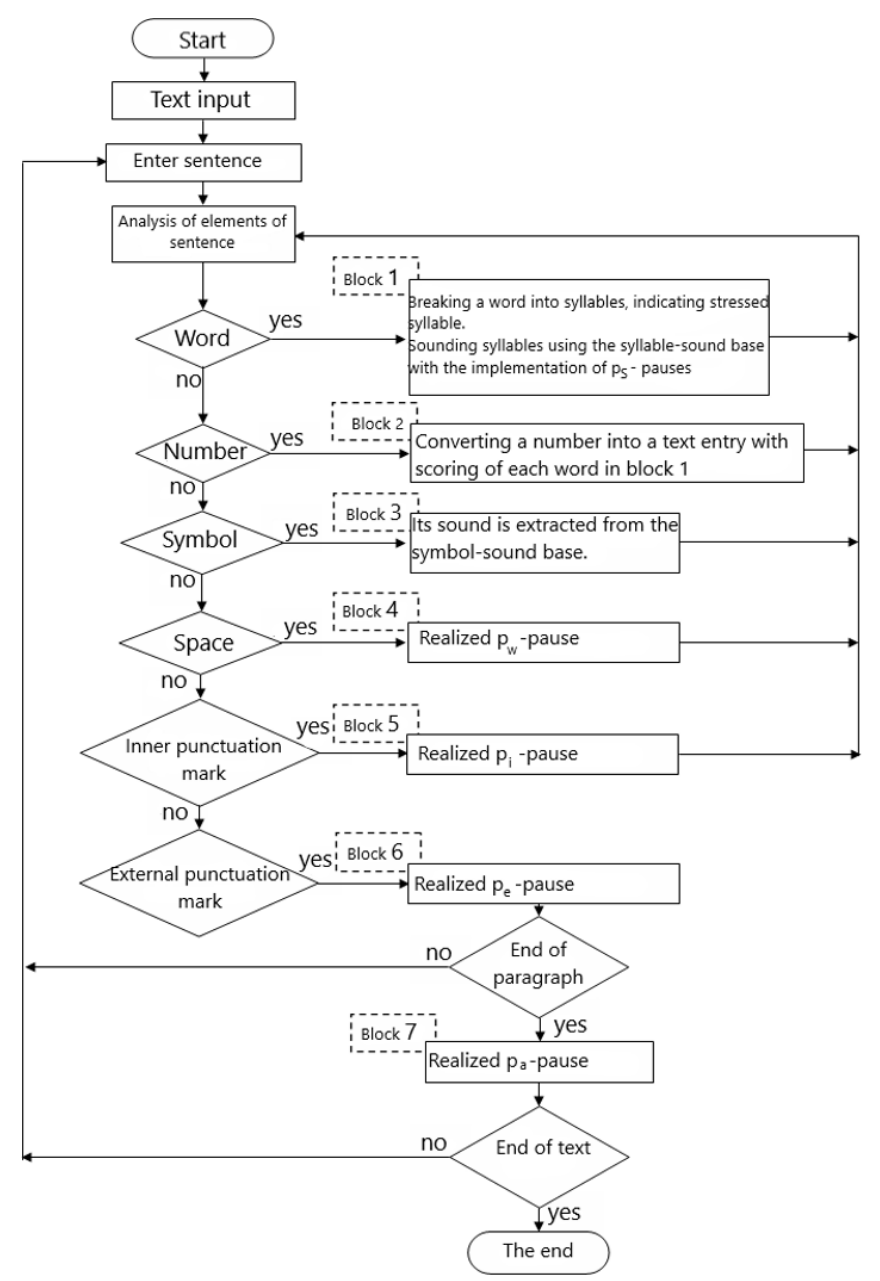
Fig. 1. Schematic diagram of the synthesis of speech in the